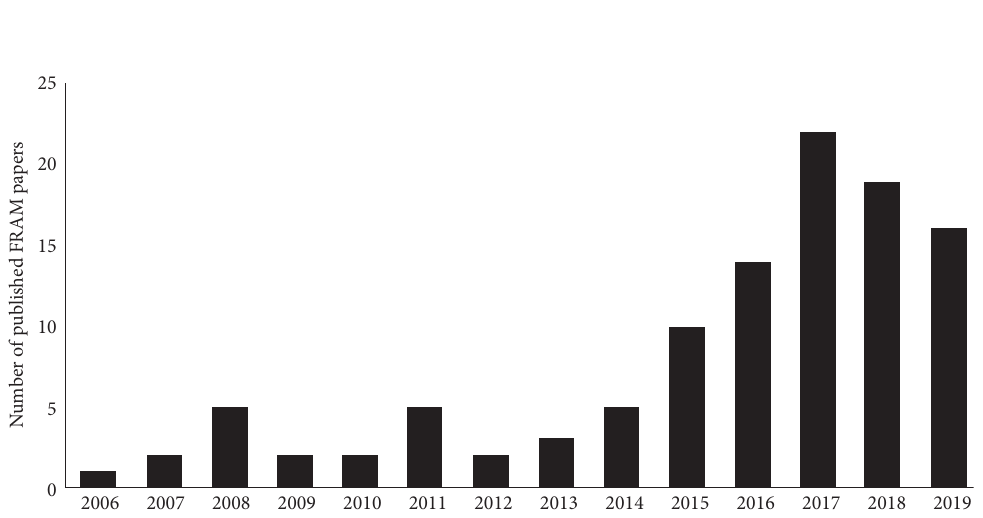
Figure 4: The number of published papers from 2006–2019.